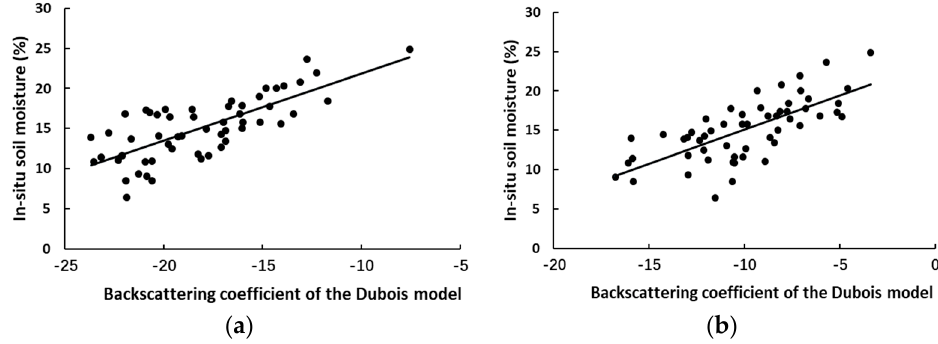
Figure 10. T he scatter plot of the backscattering coefficient of the Dubois model and in situ soil Figure 10. The scatter plot of the backscattering coe ffi cient of the Dubois model and in situ soil moisture moisture ( a ) HH polarization ( b ) VV polarization. ( a ) HH polarization ( b ) VV polarization.